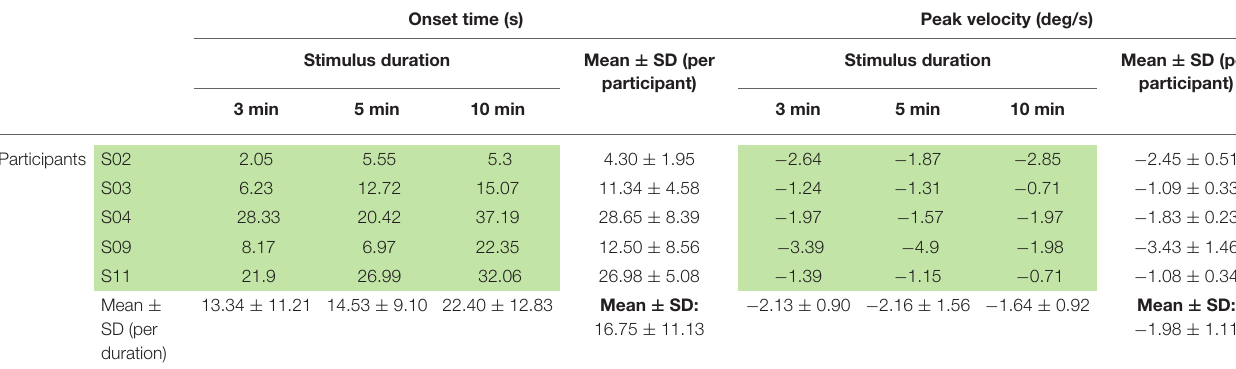
TABLE 2B | OKAN-II onset time (s) and peak velocity (deg/s).